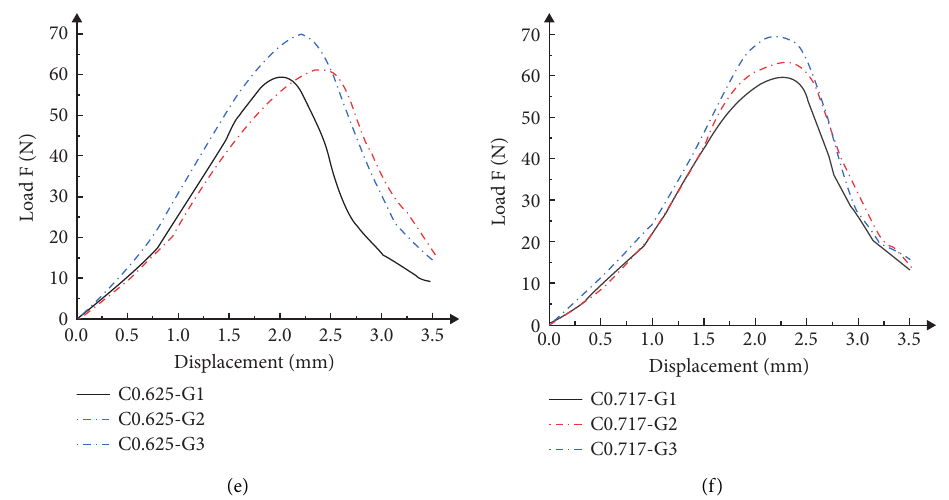
Figure 10: The load-displacement curves of six offset ratios of TPB test: (a) C ˆ 0; (b). C ˆ 0.25; (c) C ˆ 0.375; (d) C ˆ 0.5; (e) C ˆ 0.625; and (f) C ˆ 0.717.